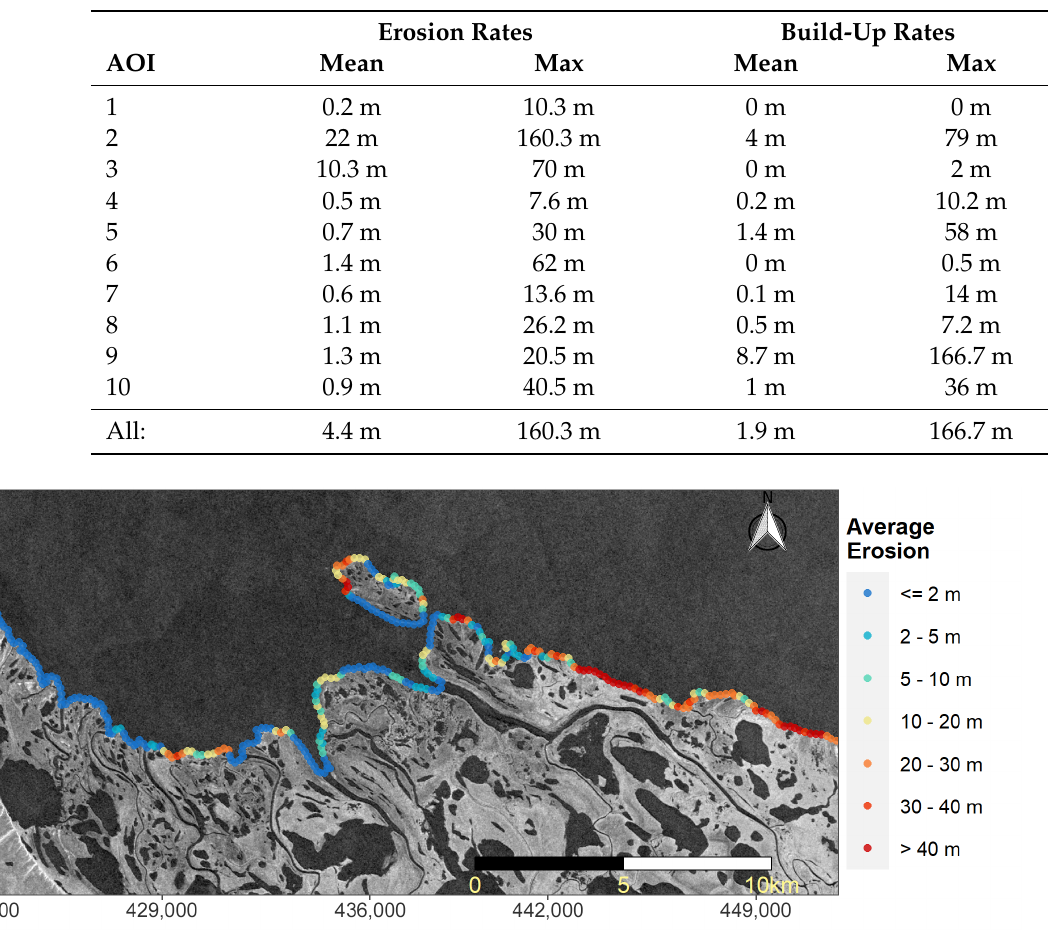
Figure 11. Average erosion rates between 2017 and 2020 for 200 m segments along Shoalwater Bay in Canada (aoi 03). A S1 median VV backscatter image of the year 2020 (months June–September) is used as a background